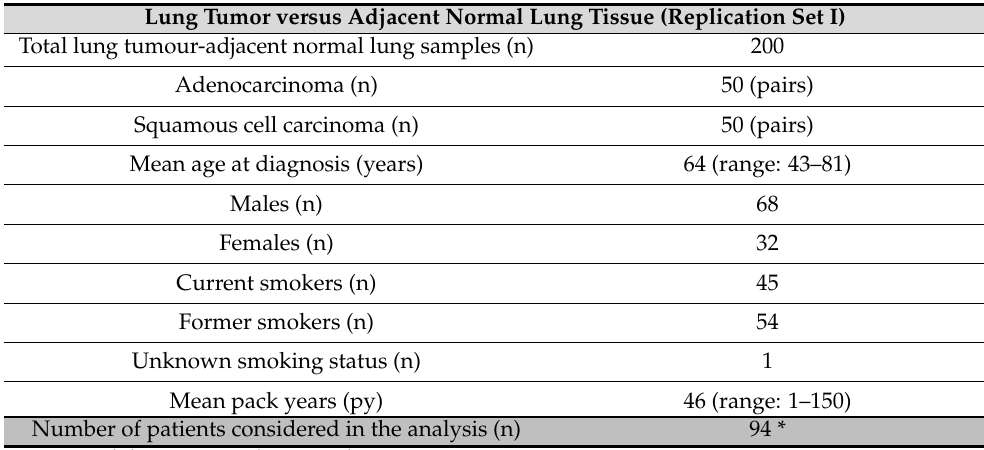
Table 3. Characteristics of the lung tumor versus adjacent normal lung tissue (Replication set I). Lung Tumor versus Adjacent Normal Lung Tissue (Replication Set I) Total lung tumour-adjacent normal lung samples (n) 200 Adenocarcinoma (n) 50 (pairs) Squamous cell carcinoma (n) 50 (pairs) Mean age at diagnosis (years) 64 (range: 43–81) Males (n) 68 Females (n) 32 Current smokers (n) 45 Former smokers (n) 54 Unknown smoking status (n)